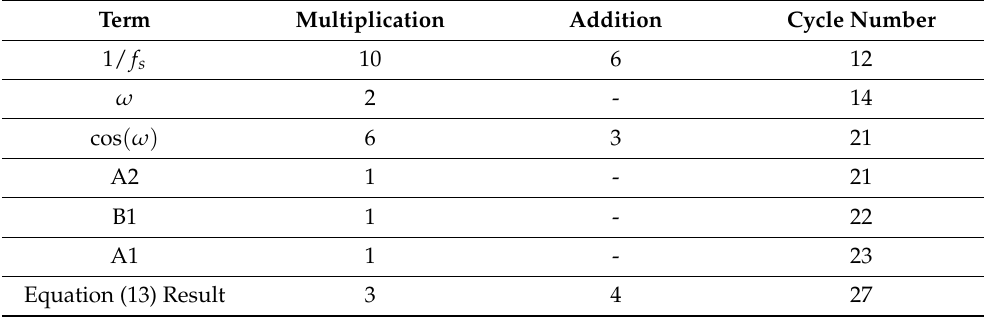
Table 3. Multiplication/Addition operations and cycle number to compute filter Equation (13).